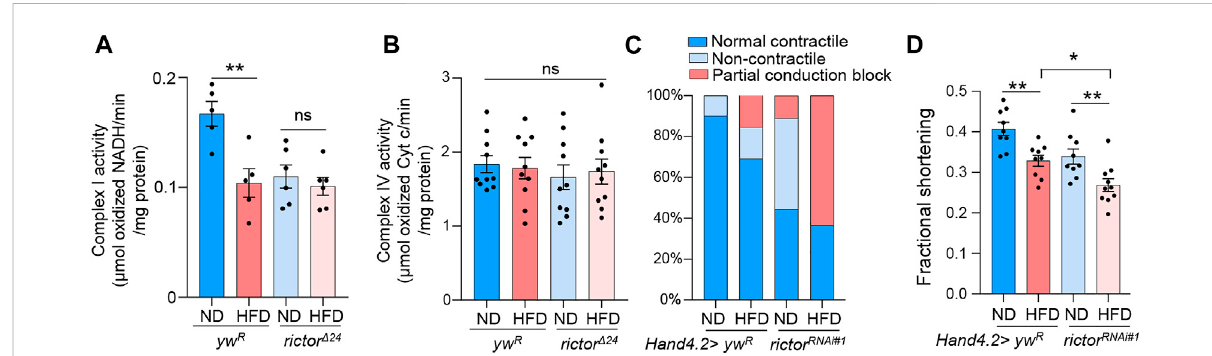
FIGURE 2 RictorisrequiredforcardiacprotectionandmitochondrialfunctionunderHFD. (A) ThecomplexIactivityofthewild-typeand rictor mutant fl ies under ND or HFD treatment. Two-way ANOVA: Interaction between diet and genotype is signi fi cant, p = 0.0211. Tukey ’ s multiple comparison test: ** p < 0.01,ns: notsigni fi cant.N=5~6(5~6 replicates, 20 fl iesperreplicate). (B) ThecomplexIVactivityofthewild-type and rictor mutant fl iesunder NDorHFDtreatment.Two-wayANOVA:Interactionbetweendietandgenotypeisnotsigni fi cant, p =0.6614.Tukey ’